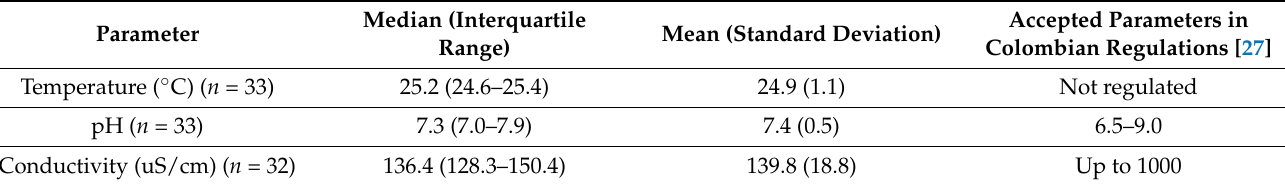
Table 2. Physicochemical properties of drinking water